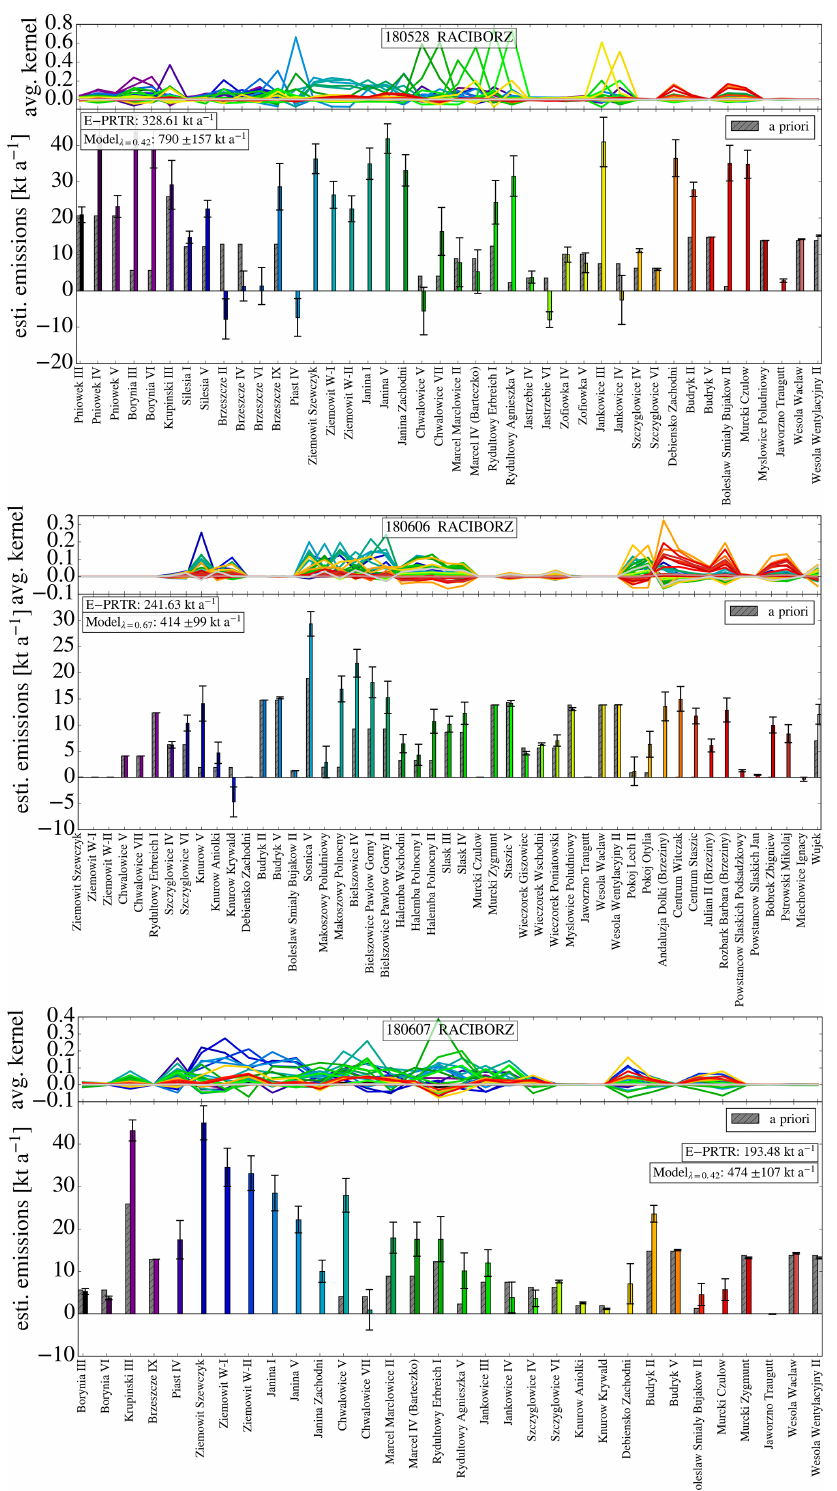
Figure 13. Shaft-wise emission estimates (lower sub-panels) for the three case studies at the western station Raciborz and the corresponding emissions averaging kernels (upper sub-panels). Colors of the shaft-wise emission estimates resemble colors of the emissions averaging kernel. Error bars contain atmospheric variability and observational uncertainty (measurement noise and background variability). Grey bars illustrate the a priori emission